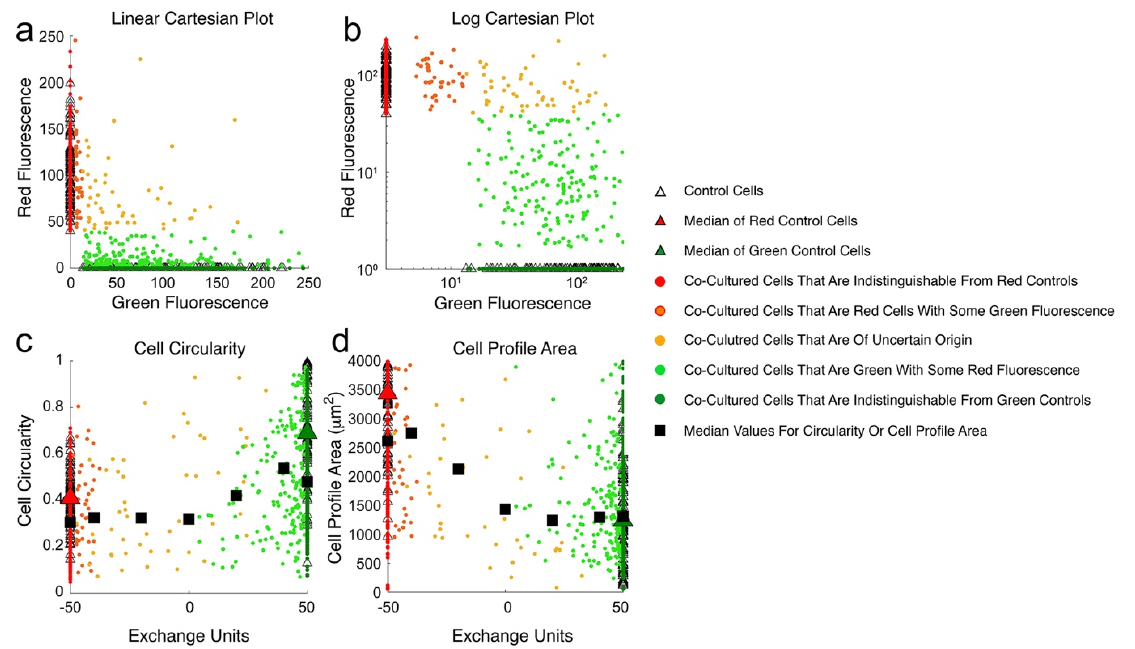
Figure 3. Cartesian plot analysis for cell circularity and cell surface area profile of an illustrative experiment (experiment ‘f’) co-culturing SAOS-2 pre-labelled with fluorescent green DiO, together with human dermal fibroblasts pre-labelled with fluorescent red DiD. Cartesian plots applying both linear ( a ) and log-scales ( b ) are shown, and the location of control cells is shown with open triangles. Cell circularity ( c ) and cell profile area ( d ) are shown for both control and co-cultured cells plotted against Exchange Units (EU). Medians are shown for both control cell populations (red and green triangles), as well as for co-cultured cells in groups of 20 ascending EU, but excluding those cells with fluorescence indistinguishable from controls. ( a ) Co-cultured cells belonging to all five cell populations as defined by the Cartesian plot method were seen in this experiment; ( b ) these are most easily distinguished when examining data in a log–log plot; ( c ) cell circularity of control SAOS-2 was greater than that of control fibroblasts ( p < 0.0001, Mann–Whitney U test). Cell circularity was lower in all groups of co-cultured cells compared with control SAOS-2 ( p < 0.025, Mann–Whitney U test); ( d ) cell-profile area of control SAOS-2 was less than that of fibroblasts ( p < 0.0001, Mann–Whitney U test), and with the exception of cells with − 50 < EU < − 30, cell profile area was higher in co-cultured cells compared with control SAOS-2 ( p < 0.0035, Mann–Whitney U